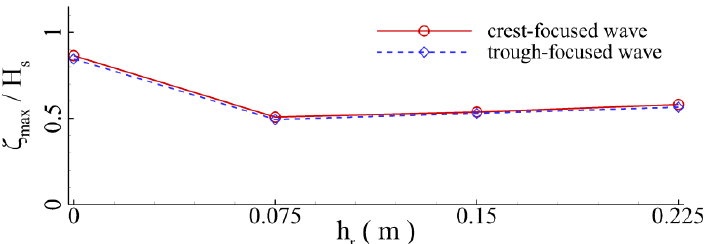
Figure 34. Space distributions of the local maximum water surface elevation.